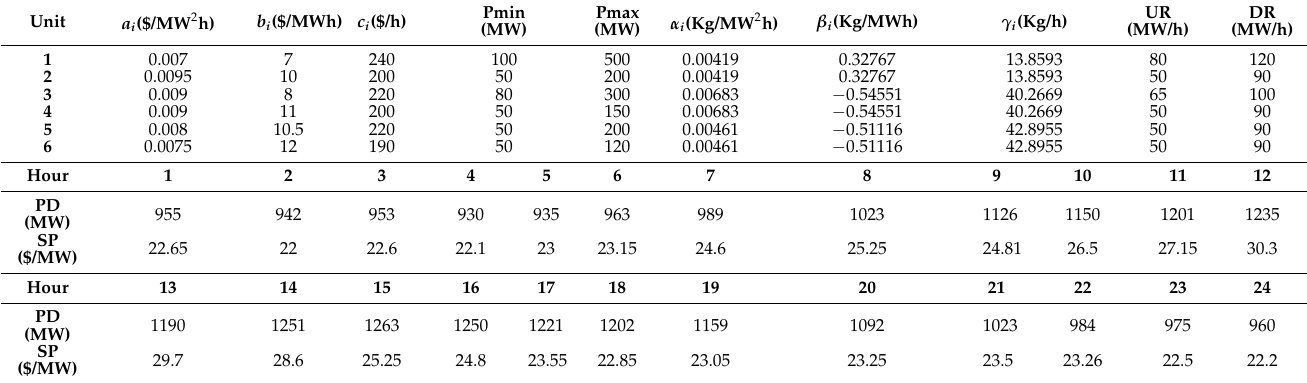
Table A1. Cost and emission coefficients and generation limits of thermal units, power demand and respective market selling price.